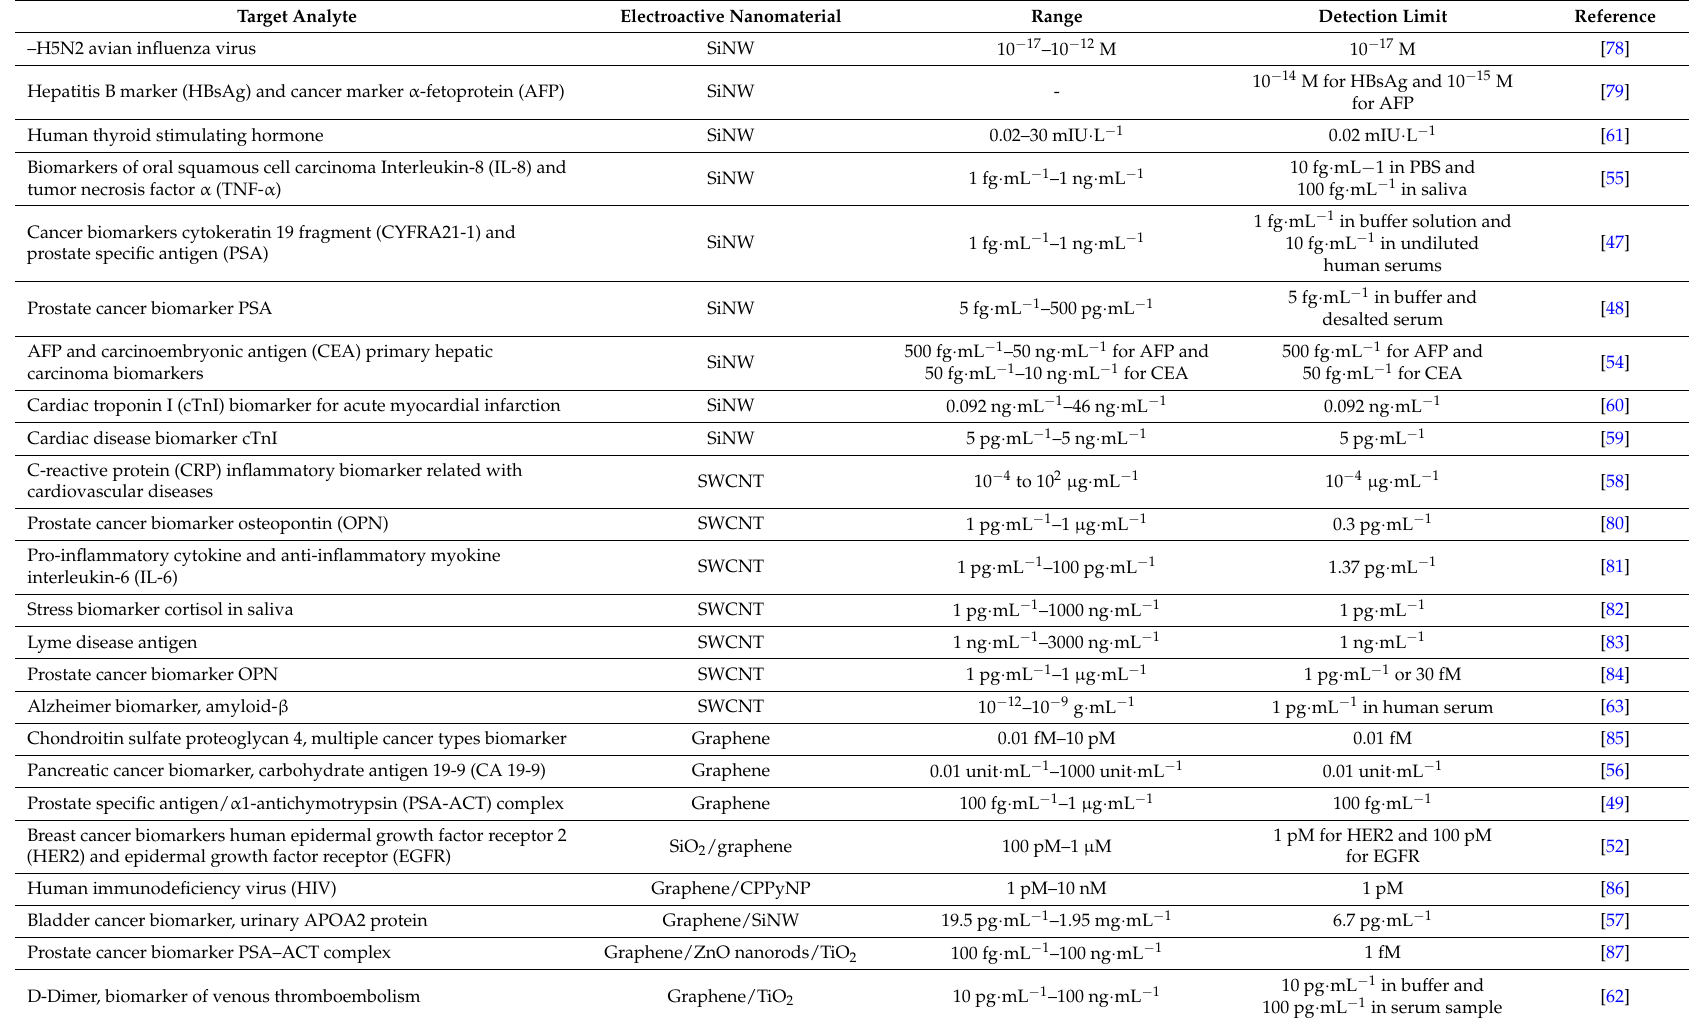
Table 1. Recent reports on immunoFET sensors based on various types of nanomaterials applied to clinical biomedical